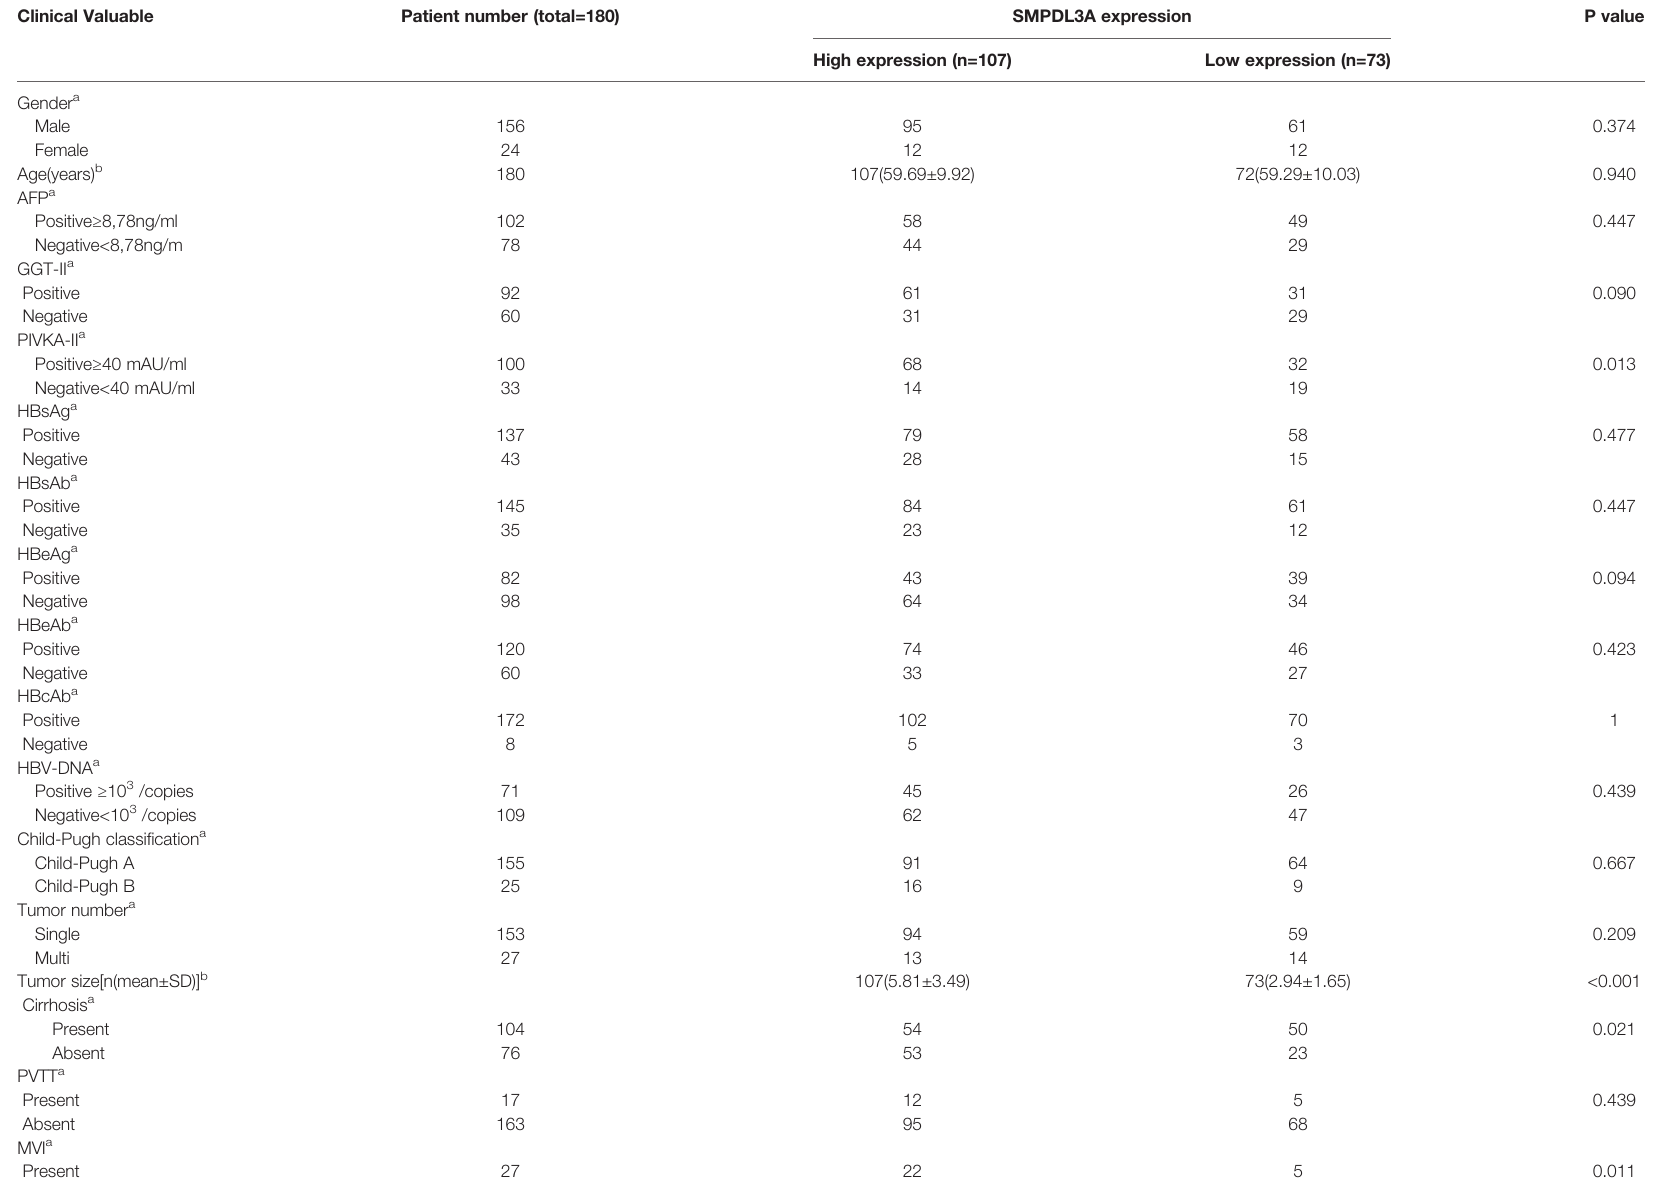
TABLE 1 | Relationship between the expression of SMPDL3A in HCC tissues and clinical characteristics of HCC patients. Clinical